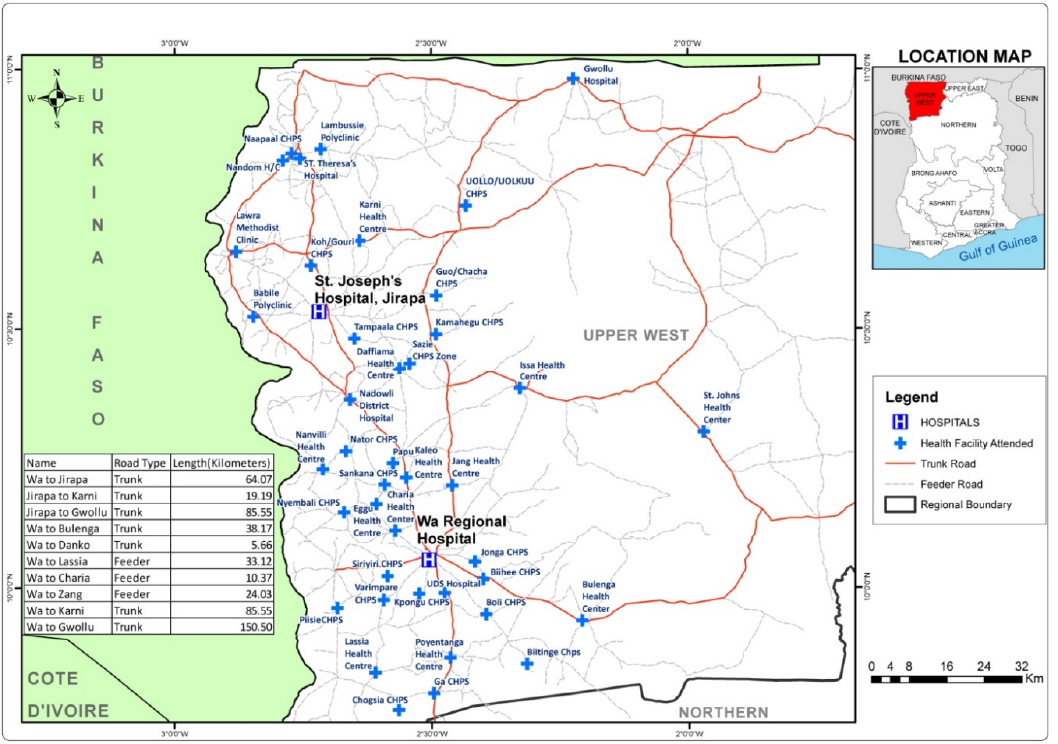
Figure 1. Health facilities attended, St. Joseph’s Hospital and Upper West Regional Hospital, in Wa, Ghana.